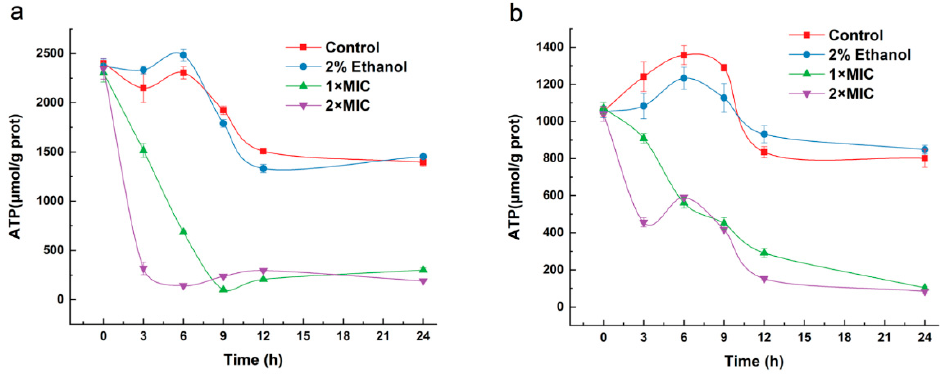
Figure 8. E ff ects of 3-carene on intracellular ATP in ( a ) B. thermosphacta and ( b ) P. Figure 8. Effects of 3-carene on intracellular ATP in ( a ) B. thermosphacta and ( b ) P. fluorescens.